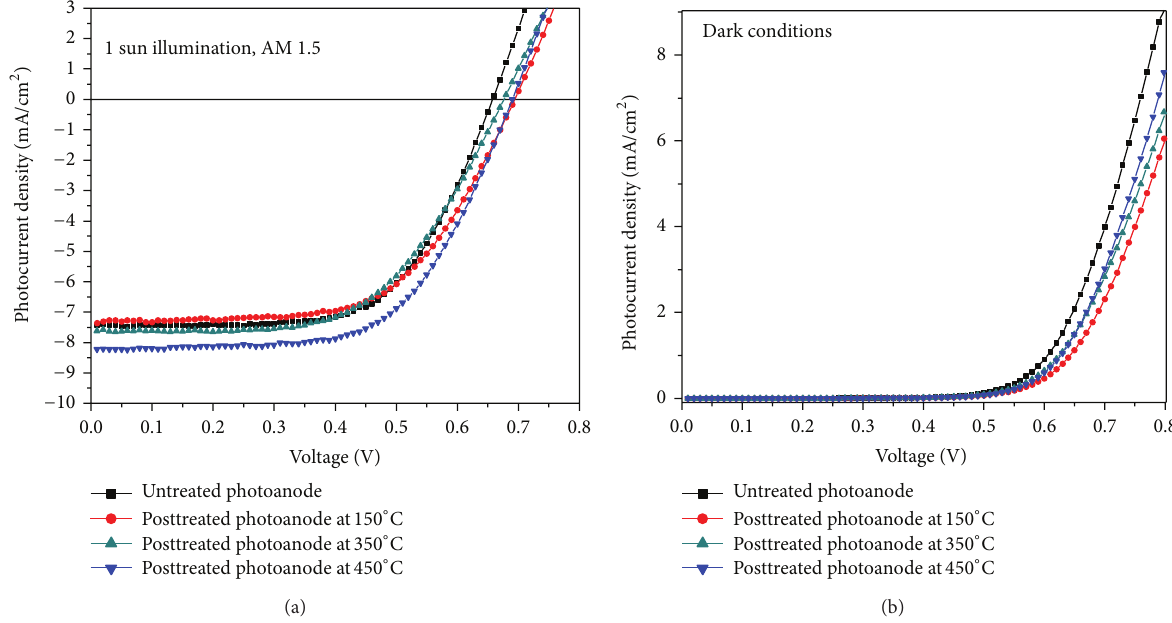
Figure 4: Photocurrent density-voltage curves measured under (a) AM 1.5 simulated light intensity at 100 mW/cm 2 (1 sun); (b) dark conditions, of DSSCs with untreated photoanode (black full square) and posttreated photoanodes with colloidal treatment at 150 ∘ C (red full circle), 350 ∘ C (green full triangle), and 450 ∘ C (blue full inverted triangle).